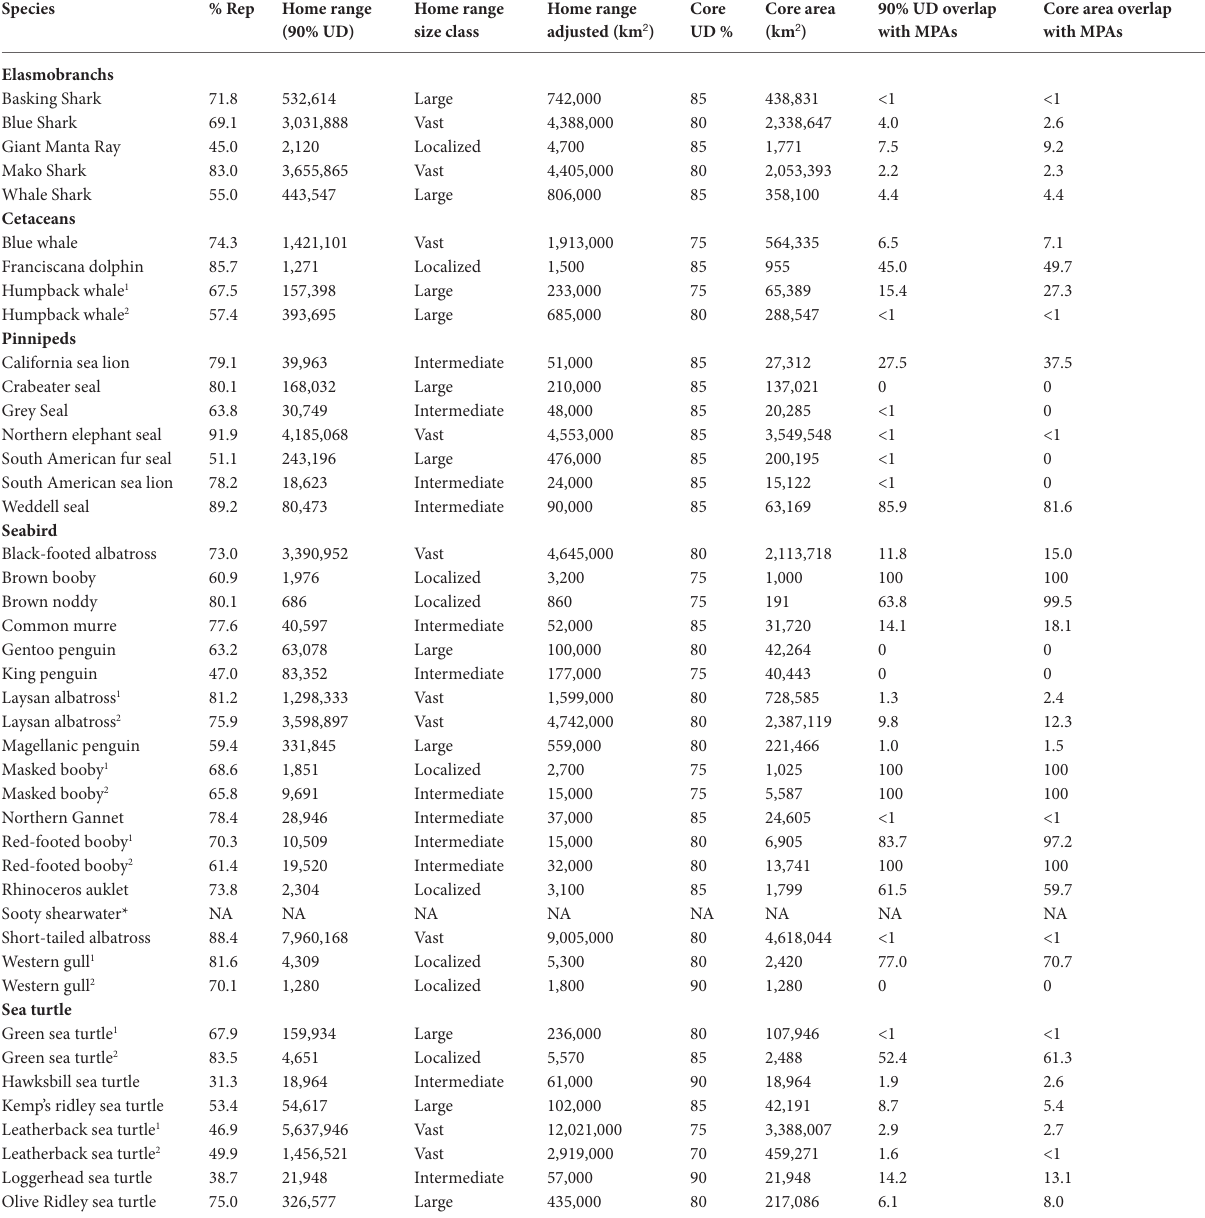
TABLE 2 Home range sizes and percent of home range and core areas that overlap with existing